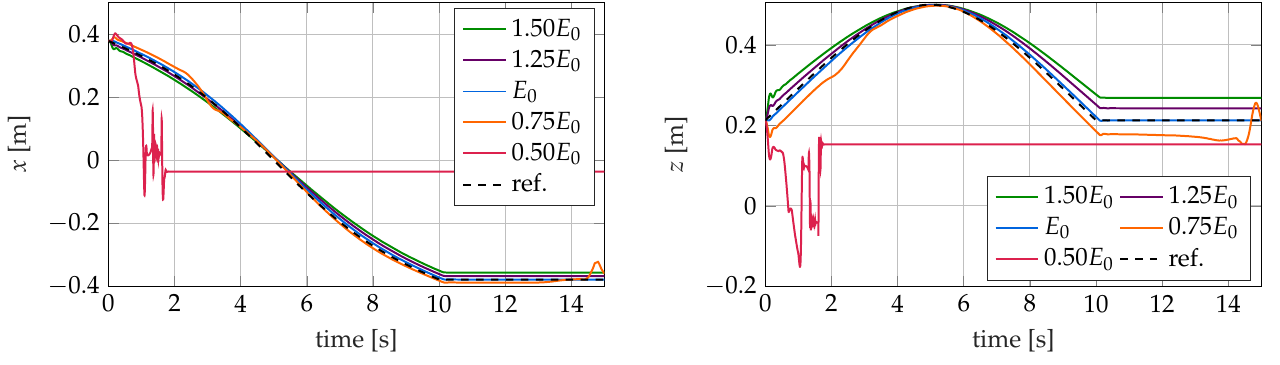
Figure 18. Trajectories of the tip position for the MPC for different values of the young’s modulus E